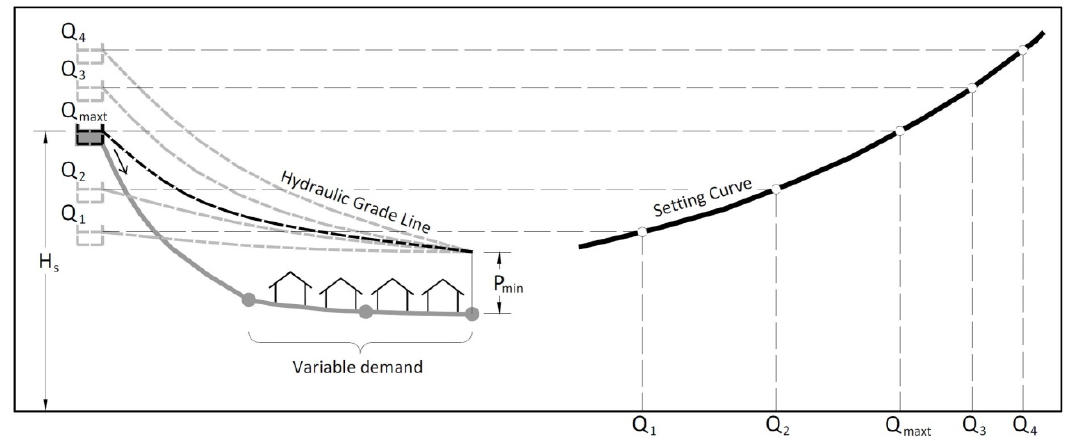
Figure 3. Representation of setting curve and theoretical maximum flow.